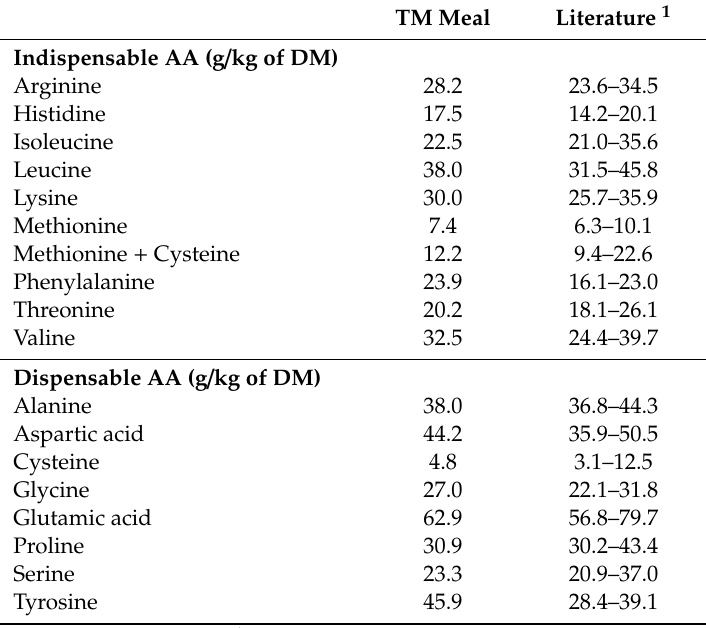
Table 3. Amino acid profile of T. molitor (TM) meal used in the study compared to range values in the literature (g / kg of dry matter basis). AA: amino acid composition; DM: dry